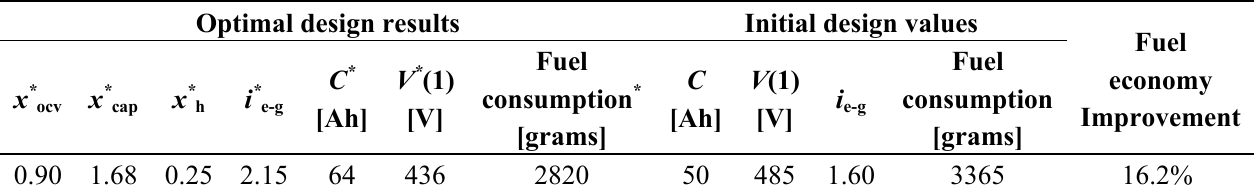
Table 2. The combined optimal design vs. the initial